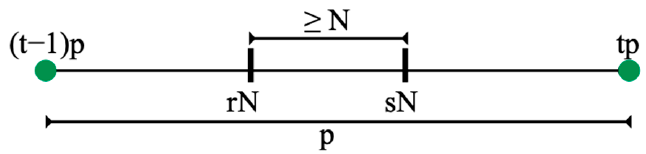
Figure 21. No two multiples of N can be enclosed by succeeding multiples of p.